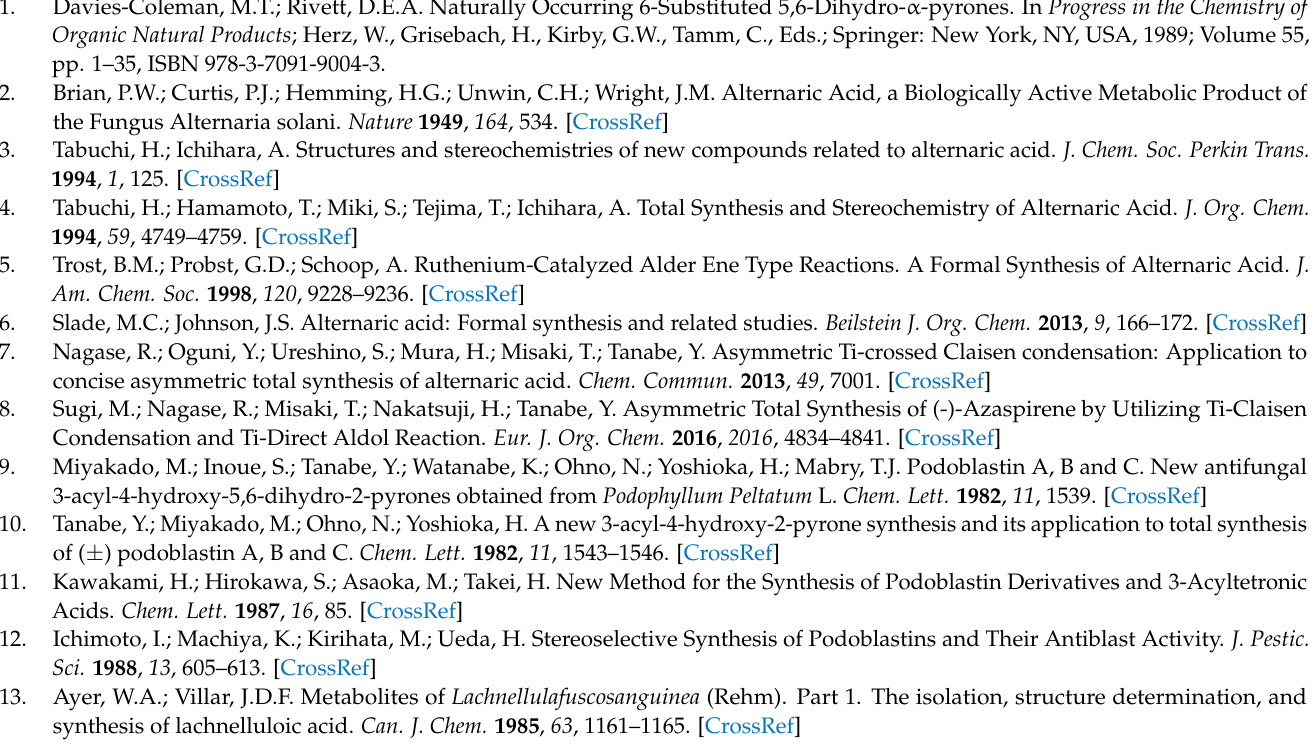
MHz, CDCl 3 ) Spectrum of the Compound 4c . Figure S22. 13 C NMR (125 MHz, CDCl 3 ) Spectrum of the Compound 4c . Figure S23. 1 H NMR (500 MHz, CDCl 3 ) Spectrum of the Compound 4d . Figure S24. 1 H NMR (500 MHz, CDCl 3 ) Spectrum of the Compound 4d . Figure S25. 13 C NMR (125 MHz, CDCl 3 ) Spectrum of the Compound 4d . Figure S26. 1 H NMR (500 MHz, CDCl 3 ) Spectrum of the Compound 4e . Figure S27. 1 H NMR (500 MHz, CDCl 3 ) Spectrum of the Compound 4e . Figure S28. 13 C NMR (125 MHz, CDCl 3 ) Spectrum of the Compound 4e . Charts of HPLC analyses for compounds 6 (racemic), ( R )-6, ( S )-6, 8 (racemic), ( R )-8, ( S )-8, 9 (racemic), ( R )-9, ( S )-9, 10 (racemic), ( R )-10, ( S )-10, 4b (racemic), ( R )-4b, ( S )-4b, 4c (racemic), ( R )-4c, ( S )-4c, 4d (racemic), ( R )-4d, ( S )-4d, 4e (racemic), ( R )-4e and ( S )-4e